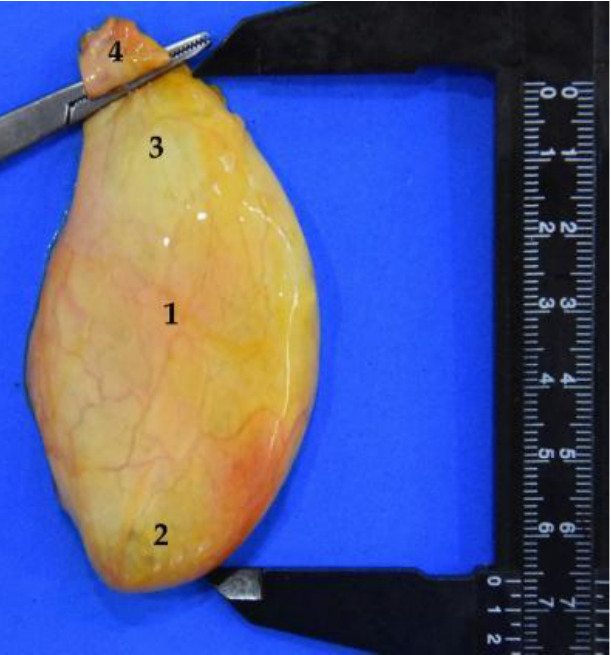
Figure 27. Isolated gallbladder. The total length can be observed, 6.5 cm. ( 1 ) Body; ( 2 ) fundus; ( 3 ) neck; ( 4 ) begining of the cystic duct. ( 3 ) neck; ( 4 ) begining of the cystic